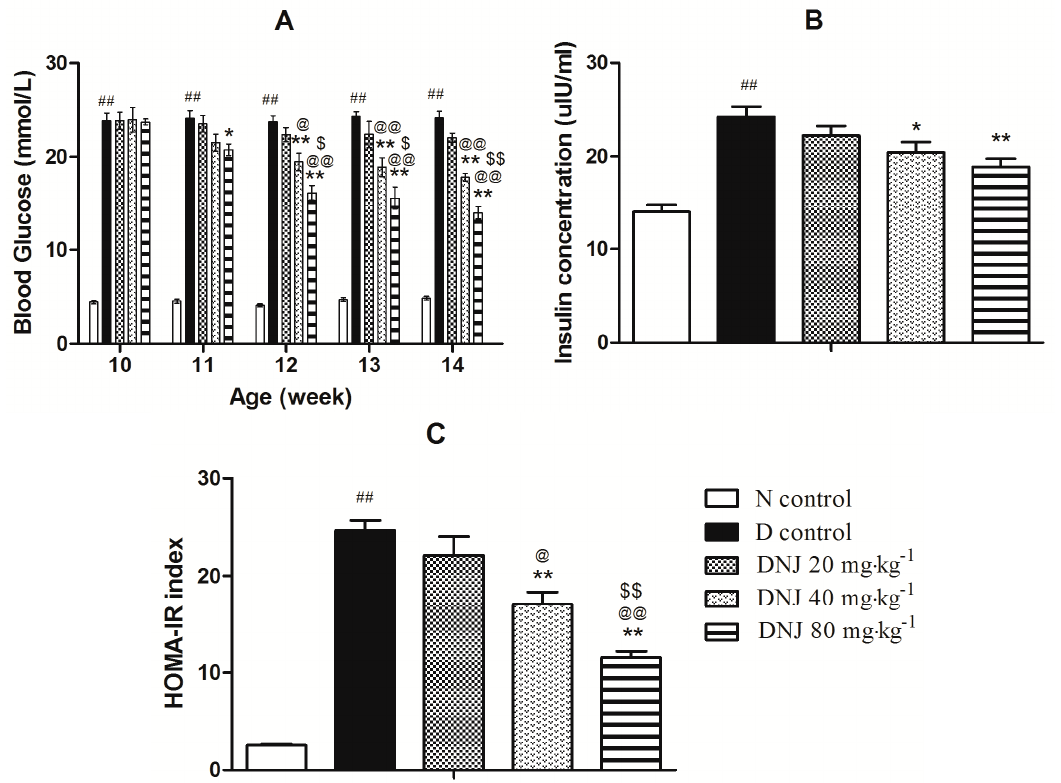
Figure 4. Antidiabetic effect of DNJ on db/db mice. Blood glucose ( A ) and serum insulin ( B ) were determined. HOMA-IR index ( C ) was calculated. ## p < 0.01 vs. N control; * p < 0.05, ** p < 0.01 vs.